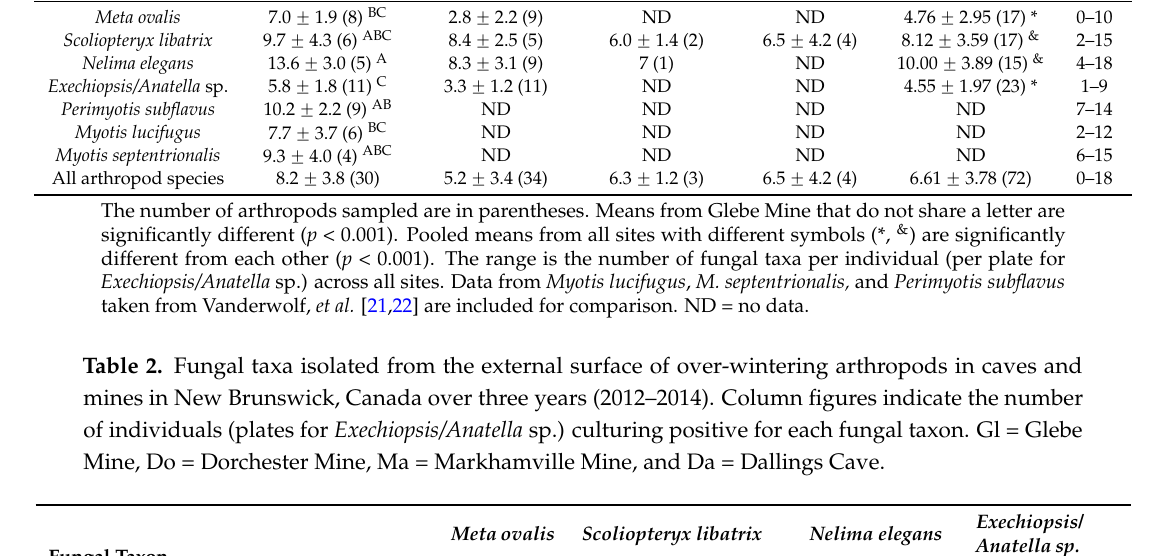
Table 1. The mean number ( ˘ standard deviation) of fungal taxa per individual arthropod (per plate for Exechiopsis/Anatella sp.) over three years in three mines and one cave in New Brunswick, Canada. Arthropod & Bat Species